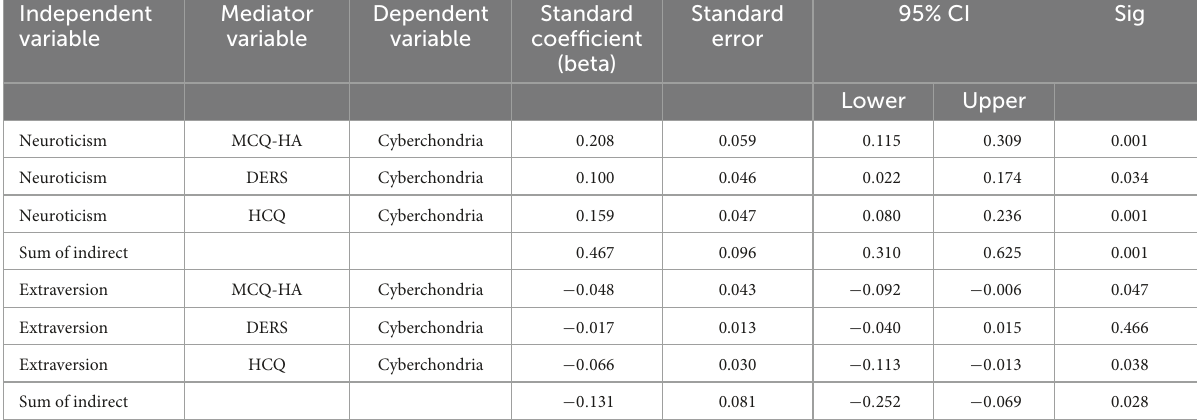
TABLE 4 Bootstrapping test indirect effect and 95% CI for the mediation model. Independent